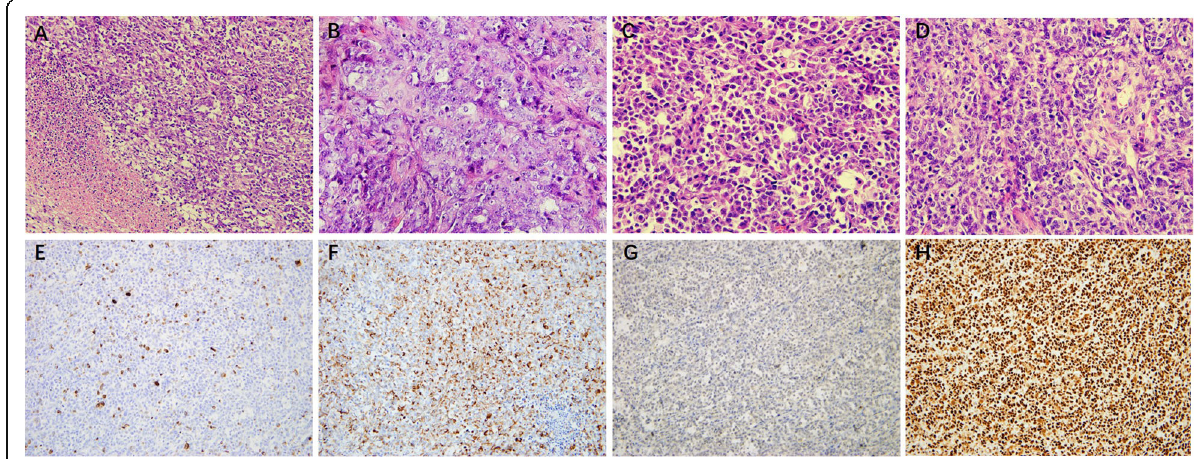
Fig. 2 Hematoxylin and eosin staining show the tumor exhibited a sheet-like structure with necrosis ( a ), vesicular nuclei and prominent nucleoli ( b ) and areas with rhabdoid morphology ( c ). The tumor cells show a high mitotic rate ( d ). Tumor cells are positive for ( e ) CK and ( f ) vimentin. SMARCA4 (BRG1) ( g ) was lost, while SMARCA2 (INI-1) ( h ) was retained in the tumor cell nuclei